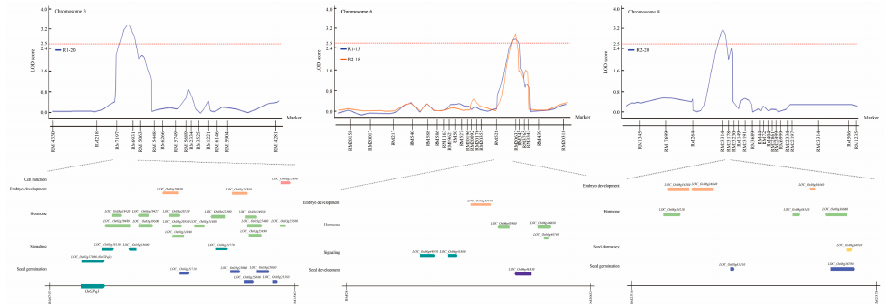
Figure 3. QTL analysis and physical mapping of seed germination-related genes. Genes associated with seed germination corresponding to cell function, embryo development, hormone, signaling, seed development, seed dormancy, and seed germination were identified in RM7197-RM15063, RM528-RM20632, and RM23314-RM23178 on chromosomes 3, 6, and 8, respectively. Among them, OSK3 ( SnRK ) which plays a key role in the ABA signaling pathway was screened.